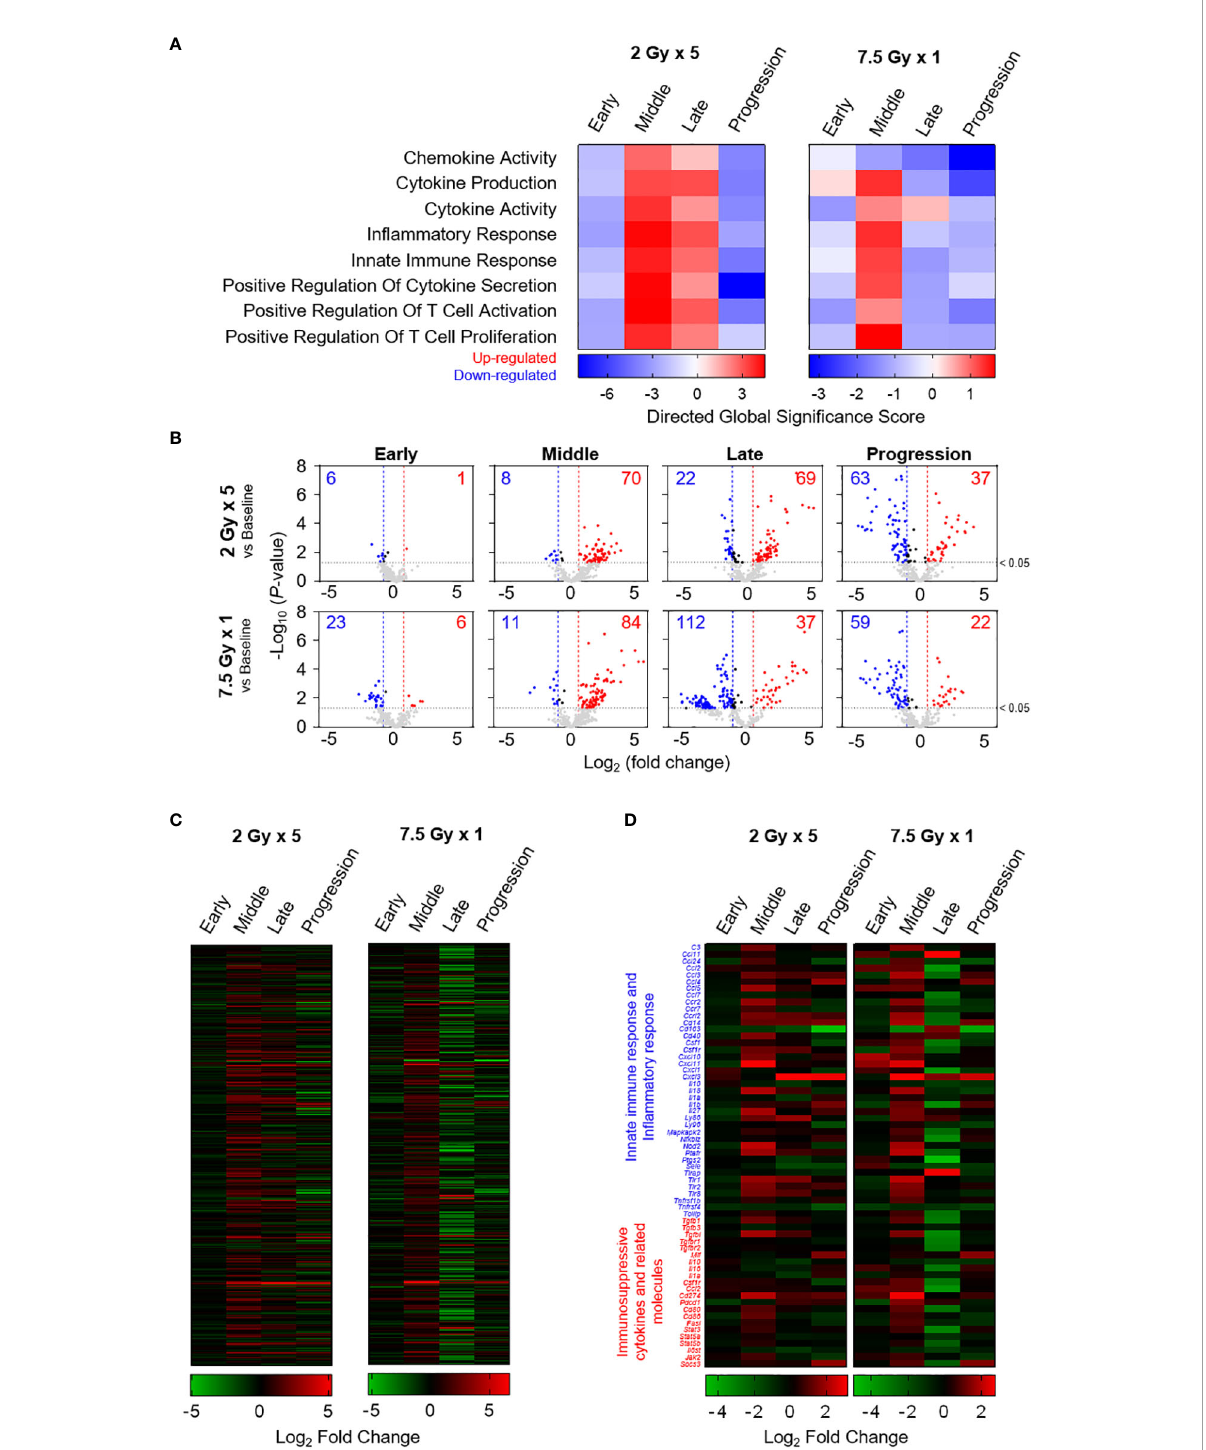
FIGURE 7 Transcriptomic analyses representing sequential alterations in the transcription levels of immunomodulatory gene sets. (A) Directed global signi fi cance scores revealing the altered patterns of categorized gene signatures. (B) Volcano plots representing the expression levels of transcripts at each time phase as indicated on each panel. Heatmaps are based on the mean Log 2 fold-change values for the expression levels of (C) 382 genes and (D) selected genes related to innate immune response, in fl ammatory response, and immunosuppressive cytokines and related molecules. These fi gures are based on the representative data obtained from at least two independent